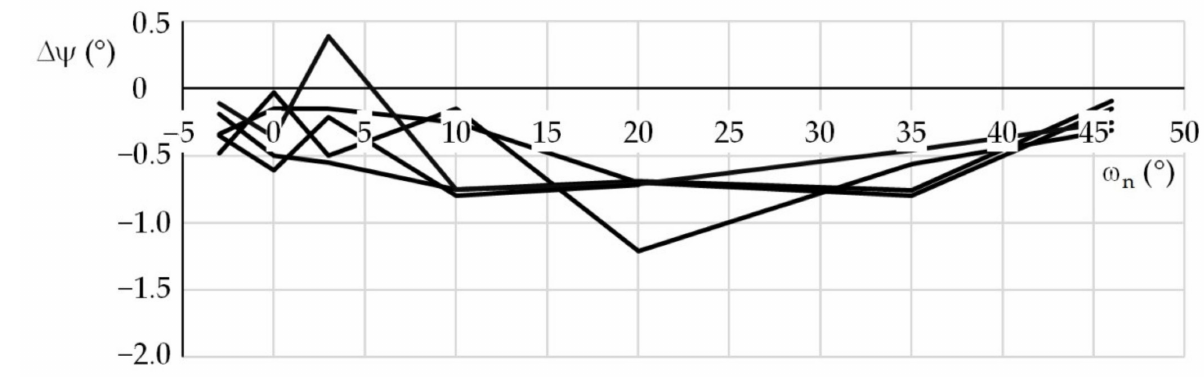
Figure 6. Elevation errors; first test, ψ n = 20 ◦ .